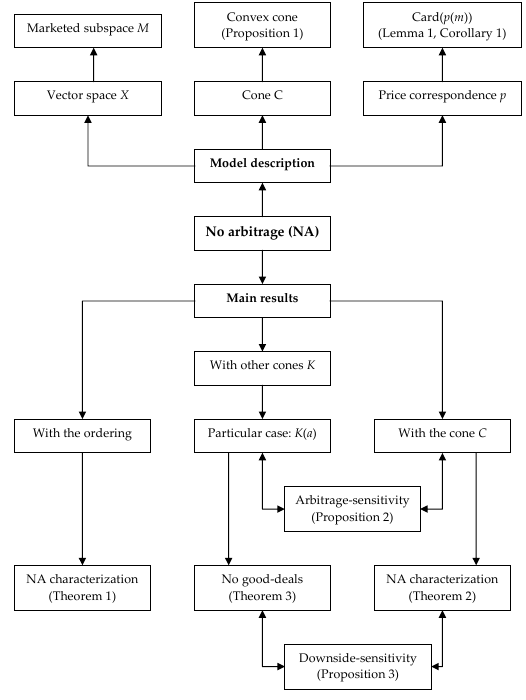
Figure 1. Structure of Sections 2–4. Source: Own